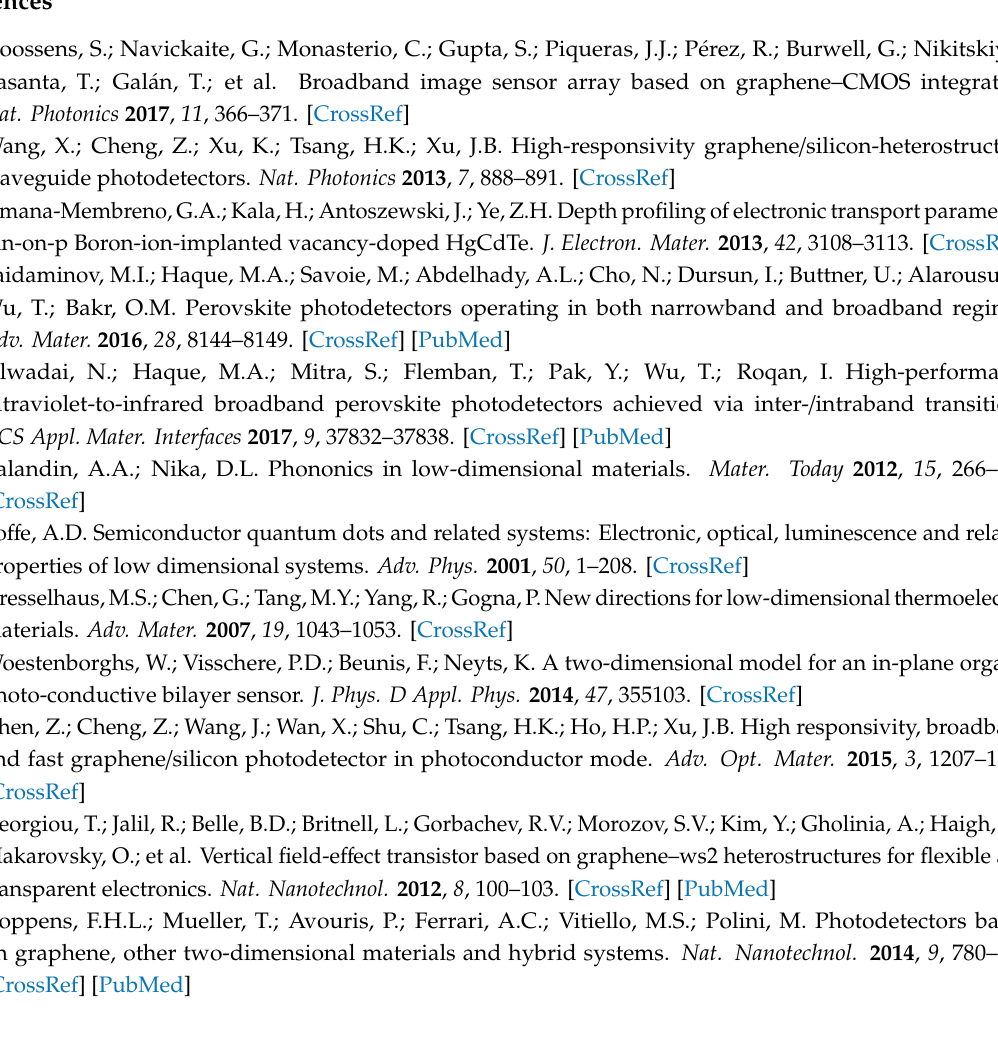
Figure S1: The digital microscopic image of an actual device; Figure S2: The SEM image of EG sample (a) and QFSG (b); Figure S3: The distribution diagram of the test points for Raman spectra; Figure S4: Three photoresponse repeat testing results of the same QFSG sample; Figure S5: Three photoresponse repeat testing results of the same EG